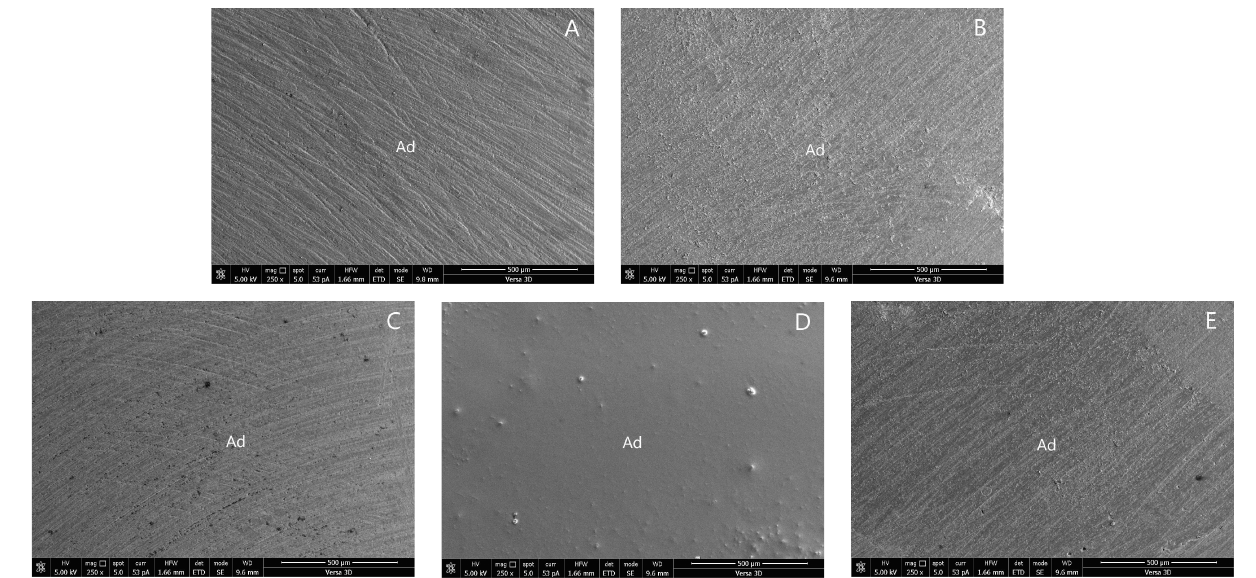
Figure 3. SEM photographs of adhesive failure mode: ( A ) group 1; ( B ) group 4; ( C ) group 5; ( D ) group 6; and ( E ) group 8. (Ad, adhesive failure).